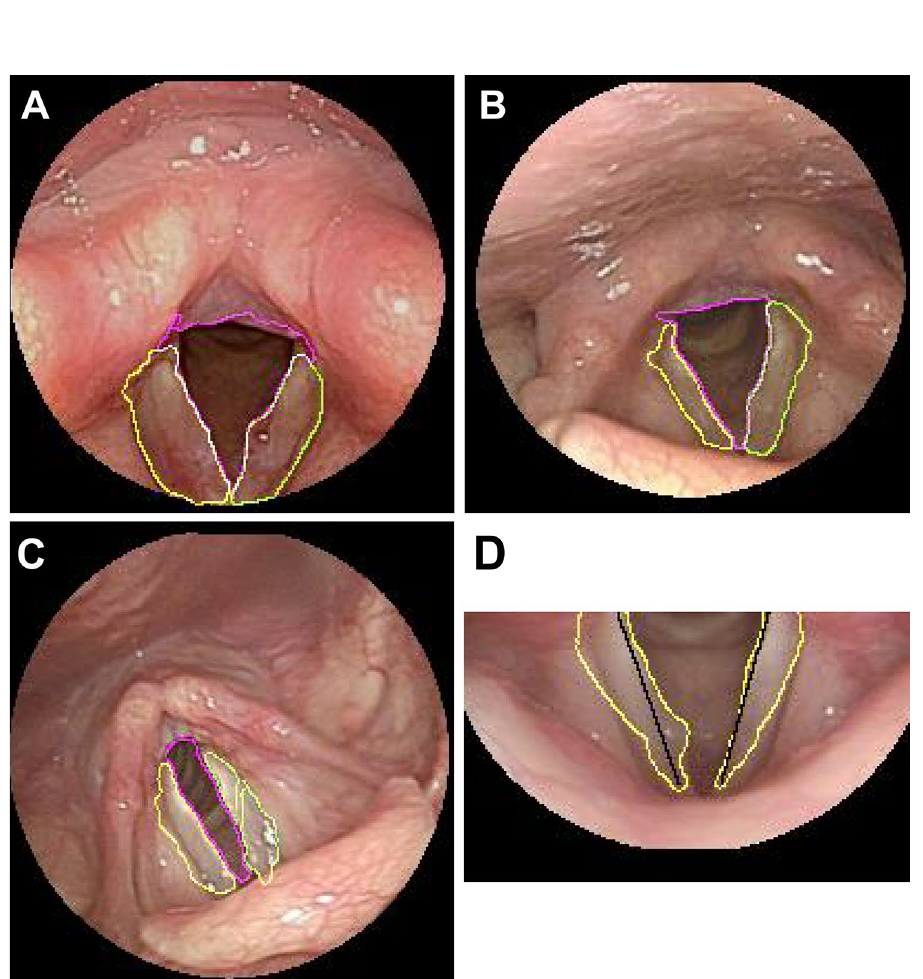
Figure 5. Adaptive vocal cord segmentation. ( A ) The number of iterations of the right and left vocal cords was 38 and 35, respectively. ( B ) The number of iterations of the right and left vocal cords was 5 and 18, respectively. ( C ) The number of iterations of the right and left vocal cords was 22 and 20, respectively. ( D ) Vocal image (yellow) and two straight lines (black) were used to calculate the geometric